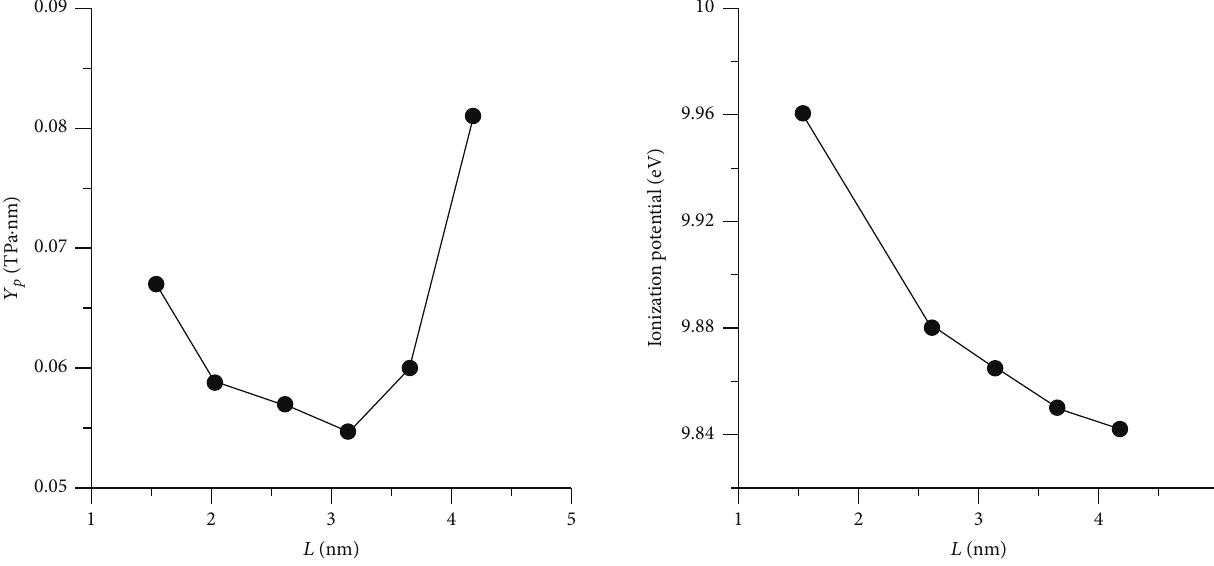
Figure 3: Dependence of the pseudo-Young’s modulus on the graphane nanoflake length.